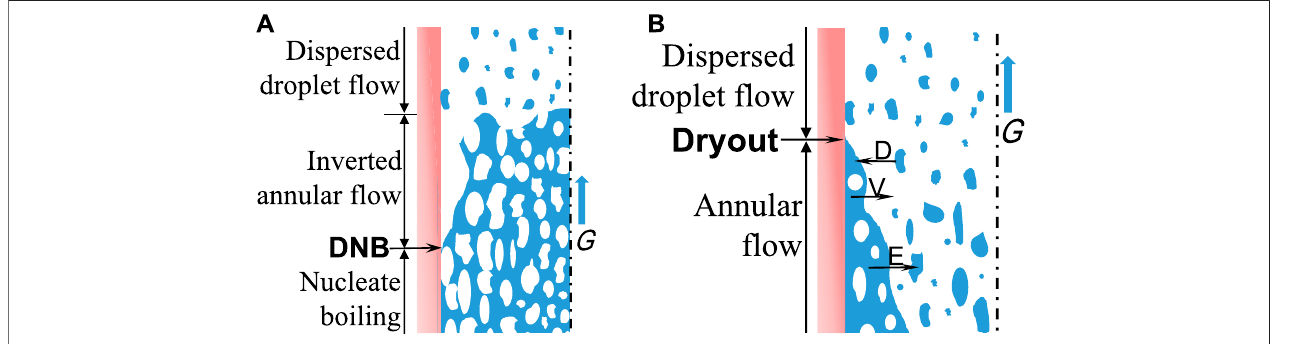
FIGURE 3 | Sketch of fl ow patterns near the CHF point for fl ow boiling (Tong and Tang, 2018). (A) DNB. (B) Dryout.